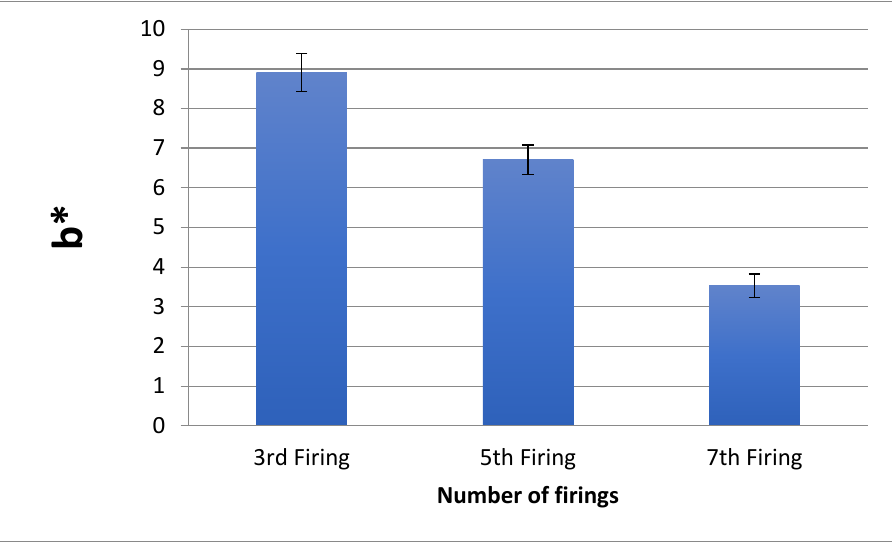
Figure 4. b* comparison of samples after the third, fifth, and seventh firings. Table 3. Means and standard deviations for Ra after the third, fifth, and seventh